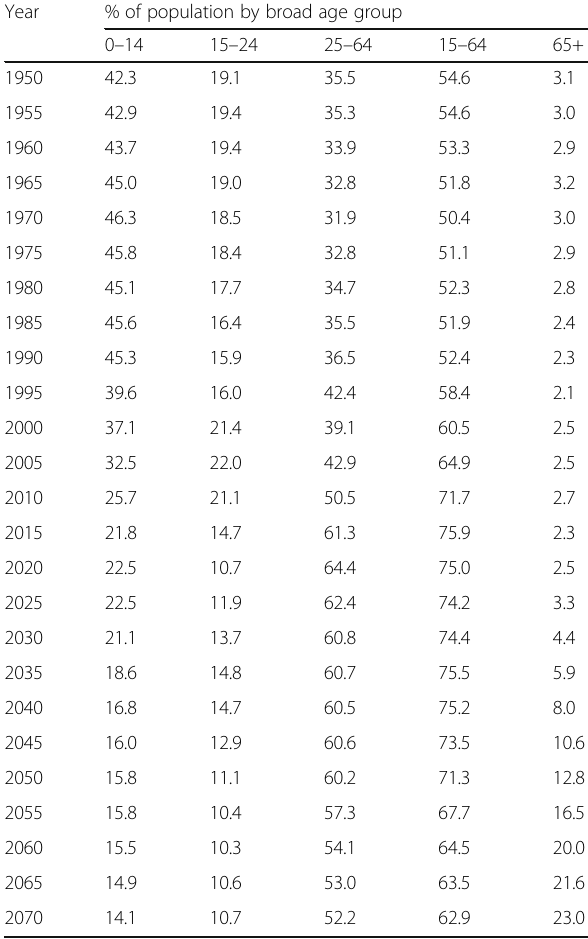
Table 2 Estimates and projections (medium variant) of percentage of population by broad age groups in Oman: 1950